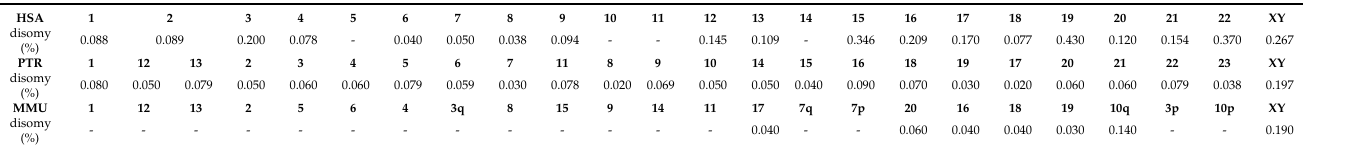
Table 4. Interspecies comparison of sperm disomy rates between Homo sapiens (HSA, 36 studies), Pan troglodytes (PTR, our study, n = 2) and Macaca mulatta (MMU, one study, n = 5).